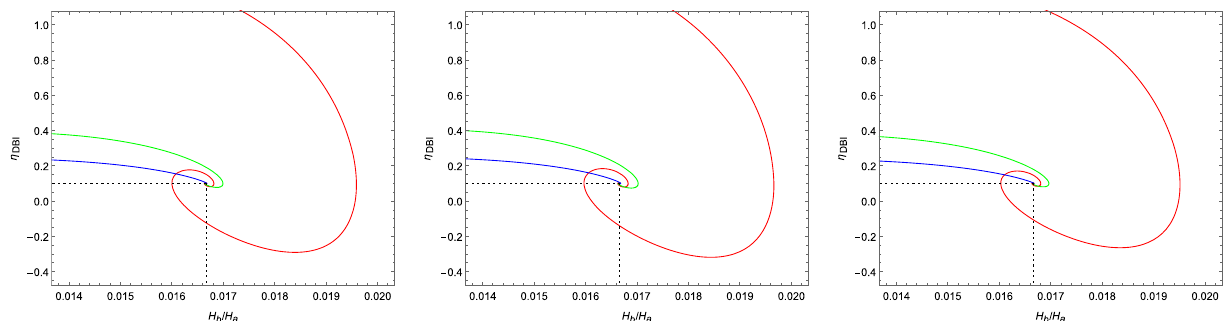
Fig. 5 Phase space of H b ( t )/ H a ( t ) and η DBI ( t ) for three different values of γ 0 . The left, middle, and right plots correspond to the solutions I, II, and III, respectively. The red, green, and blue curves correspond to γ 0 = 1, 1 . 5, and 2,